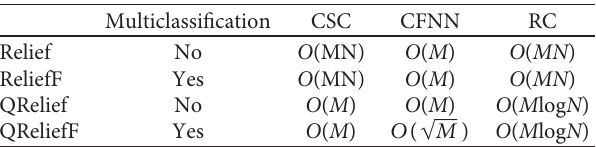
Table 3: Efficiency comparison between classical Relief, classical ReliefF, QRelief, and QReliefF